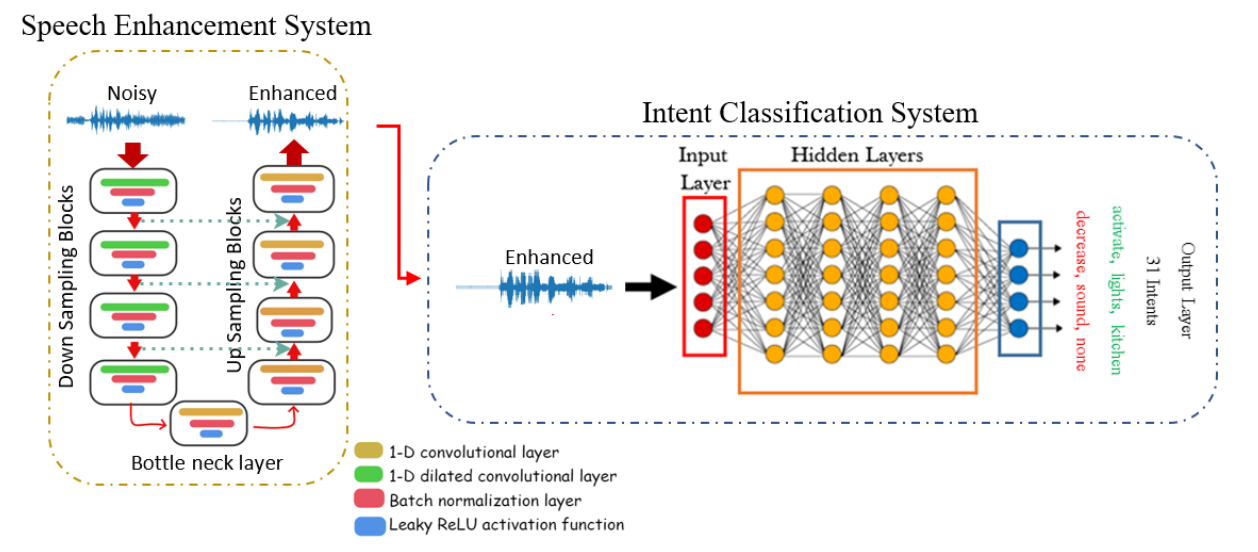
Figure 3. The full pipeline of our intent classification scheme, including speech enhancement and intent